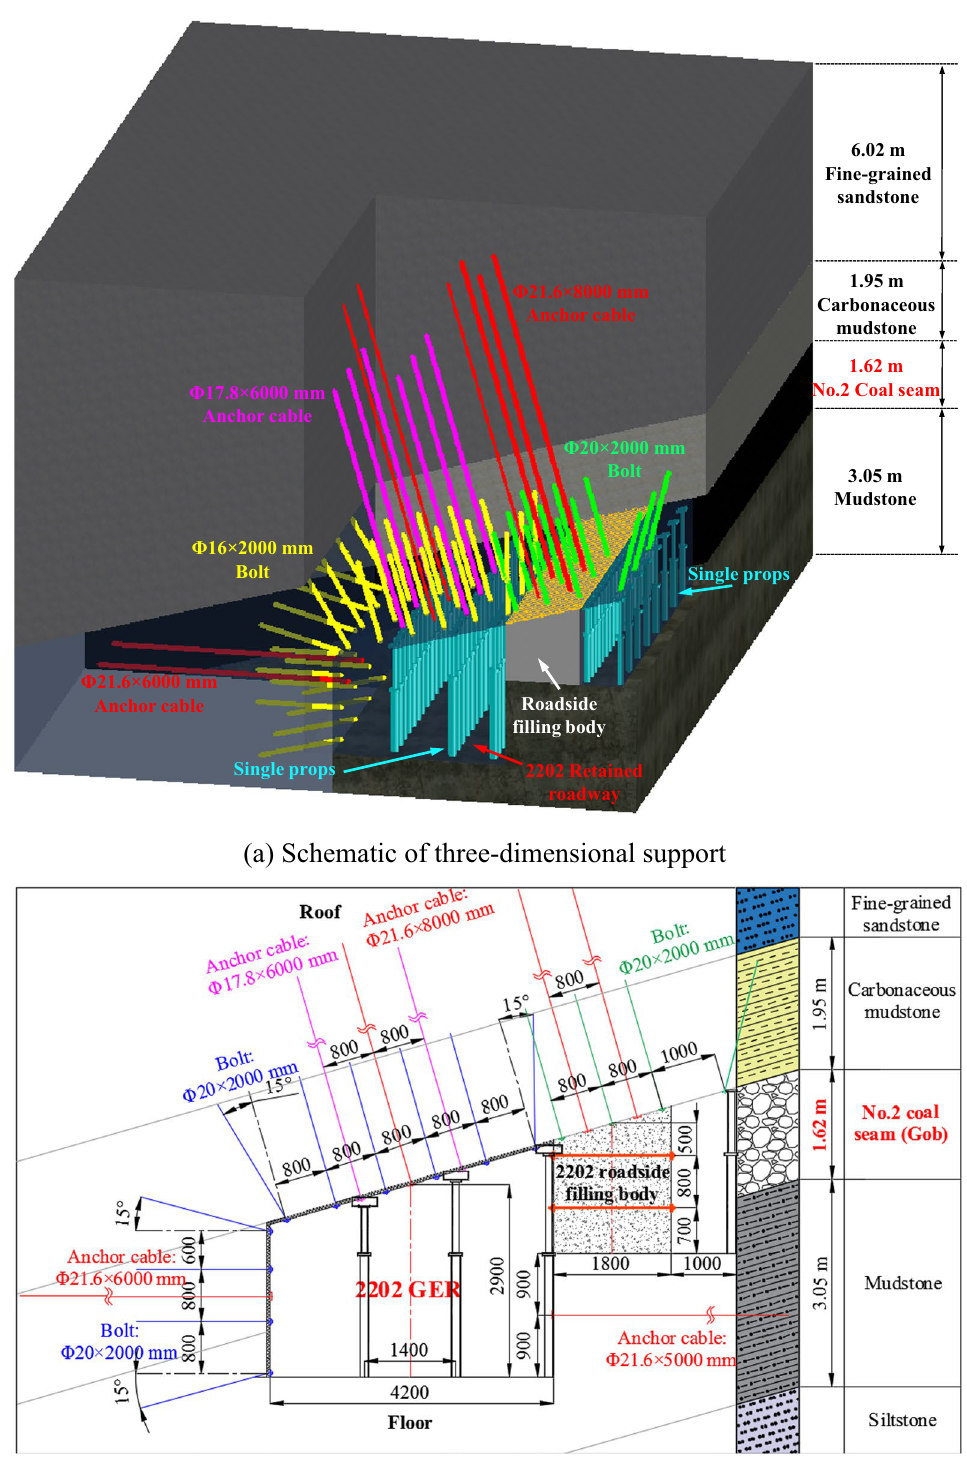
Fig. 13 Supporting scheme of 2202